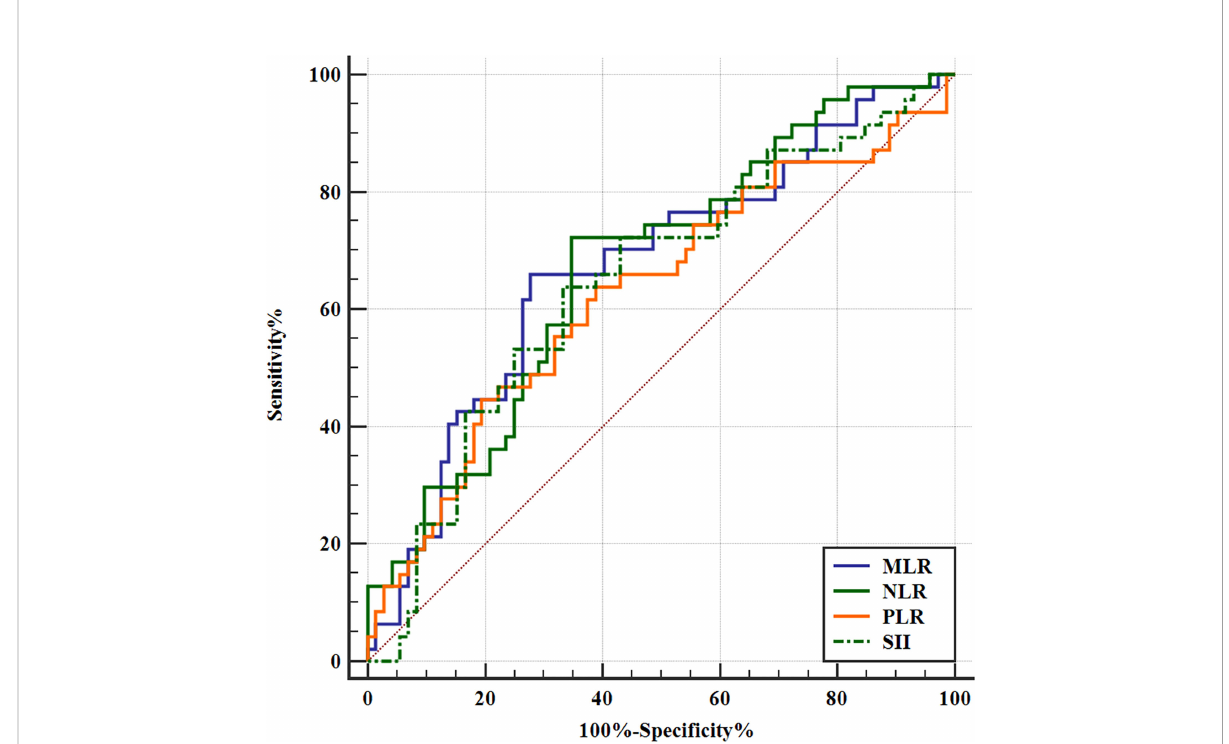
FIGURE 1 Receiver operating characteristic (ROC) curves of in fl ammatory markers for predicting binary stage of SCLC. NLR, PLR, MLR, and SII could predict the binary stage of SCLC. The ROC curve analysis of the NLR to predict ED-SCLC. With an NLR of 2.64 as the threshold, the sensitivity and speci fi city in the prediction of ED-SCLC were 72.34% and 65.28%, respectively. The AUC was 0.672 (95% con fi dence interval [CI]: 0.580 – 0.756; p = 0.0006). The ROC curve analysis of the PLR to predict ED-SCLC. With an PLR of 170.67 as the threshold, the sensitivity and speci fi city for the prediction of ED-SCLC were 44.68% and 80.56%, respectively. The AUC was 0.628 (95% CI: 0.535 – 0.715; p = 0.0178). The ROC curve analysis of the MLR to predict ED-SCLC. With an MLR of 0.31 as the threshold, the sensitivity and speci fi city for the prediction of ED- SCLC were 65.96% and 70.83%, respectively. The AUC was 0.669 (95% CI: 0.577 – 0.753; p = 0.0010). The ROC curve analysis of the SII to predict ED-SCLC. With an SII of 583.1 as the threshold, the sensitivity and speci fi city for the prediction of ED-SCLC were 63.83% and 66.67%, respectively. The AUC was 0.646 (95% CI: 0.553 – 0.731; p =